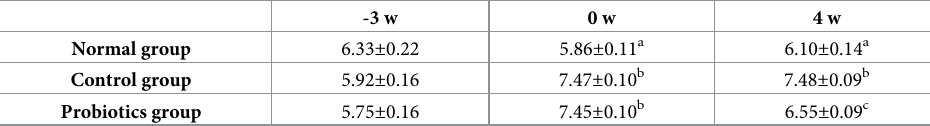
Table 6. The effect of probiotics treatment on pH of faeces in adenine-induced CKD rats. -3 w